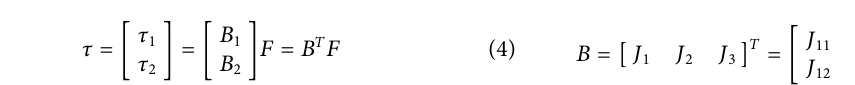
Supplementary Figure S1 layout the cable tension distribution algorithm based on the priority approach and optimization.